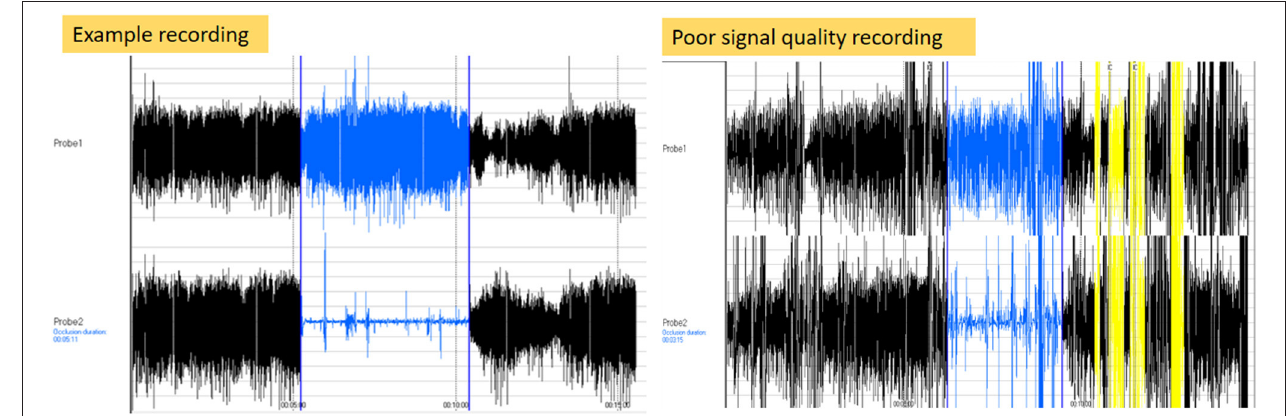
FIGURE 2 | Illustration of error recording. The left side of the figure shows a signal of a recording with a desired pulse wave pattern. The right side of the figure shows a recording with a poor signal recording.